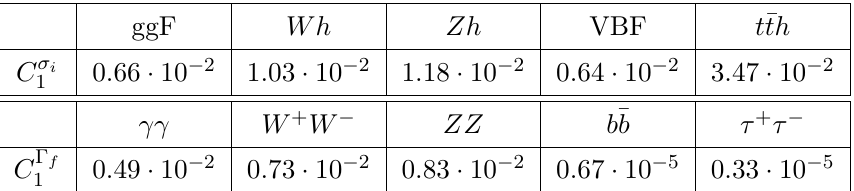
and C Γ f . The numbers are directly taken 1 1 √ correspond to pp collisions at s = 14 TeV . 1